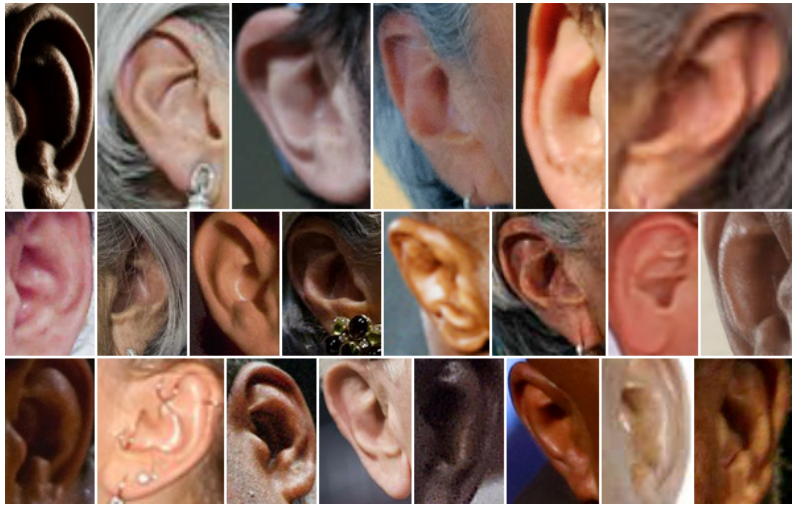
Figure 3. An example of the AWE ear database